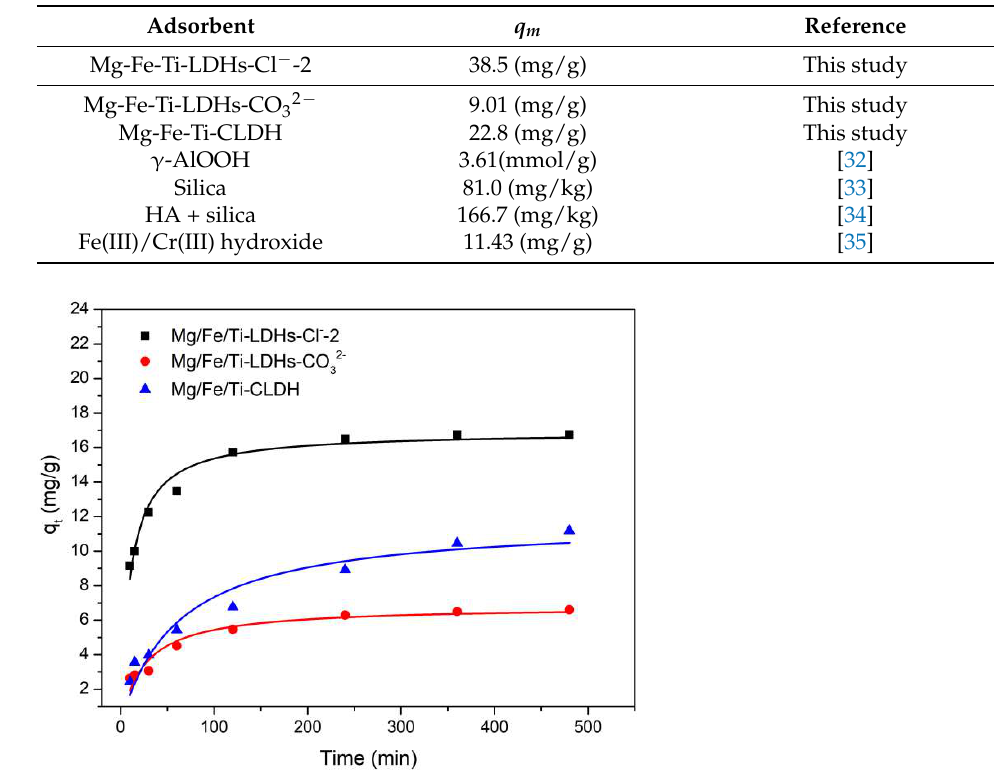
Table 2. Comparison of several reported adsorbents for vanadate.